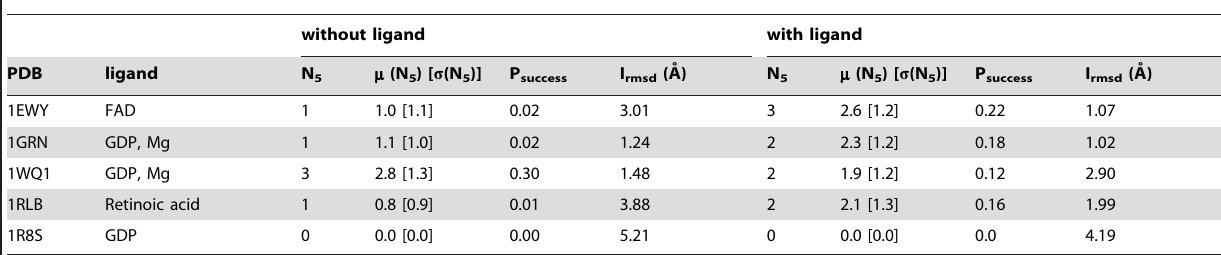
Table 5. Results of incorporating small molecules in Rosetta